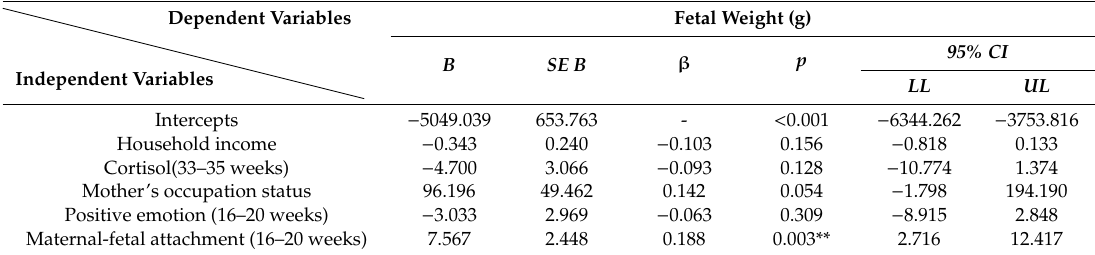
Table 4. Linear model summary for maternal emotional status, cortisol level, mother’s job status, and covariates on fetal